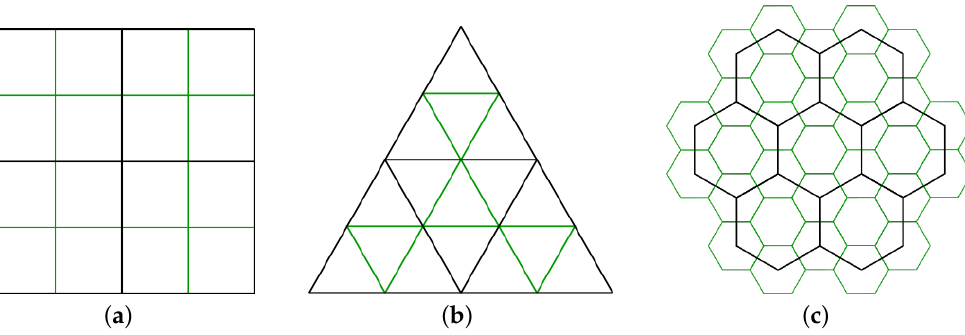
Figure 4. Examples of congruent ( a ) 1 to 4 quad, ( b ) 1 to 3 triangle, and ( c ) non-congruent hexagonal refinement. The black cells are original cells and the green lines show one level of